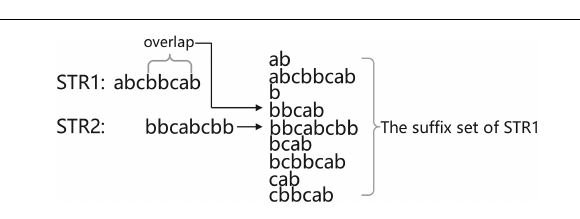
FIGURE 3 | The position of str2 in the suffix set of